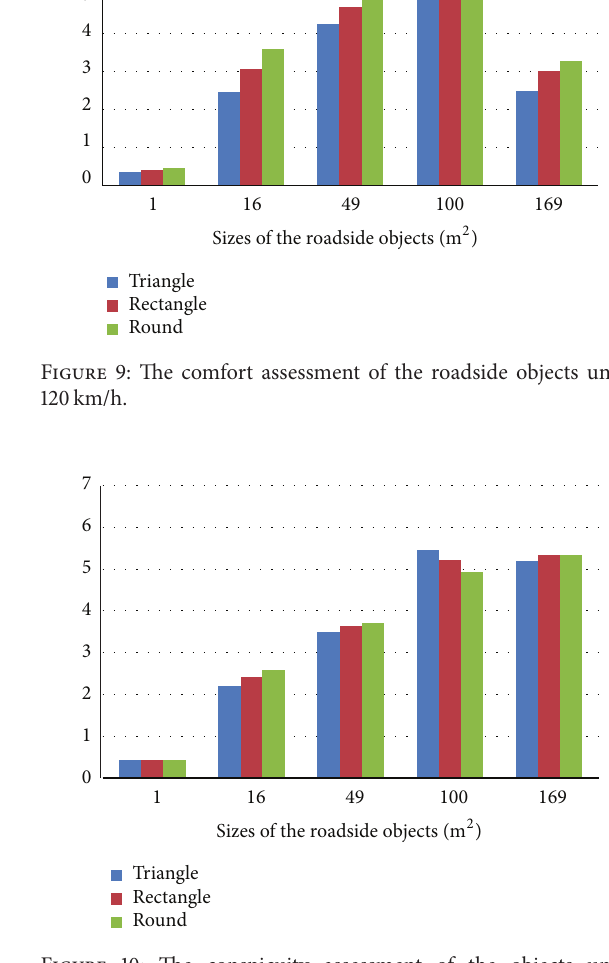
Figure 10: The conspicuity assessment of the objects under 120